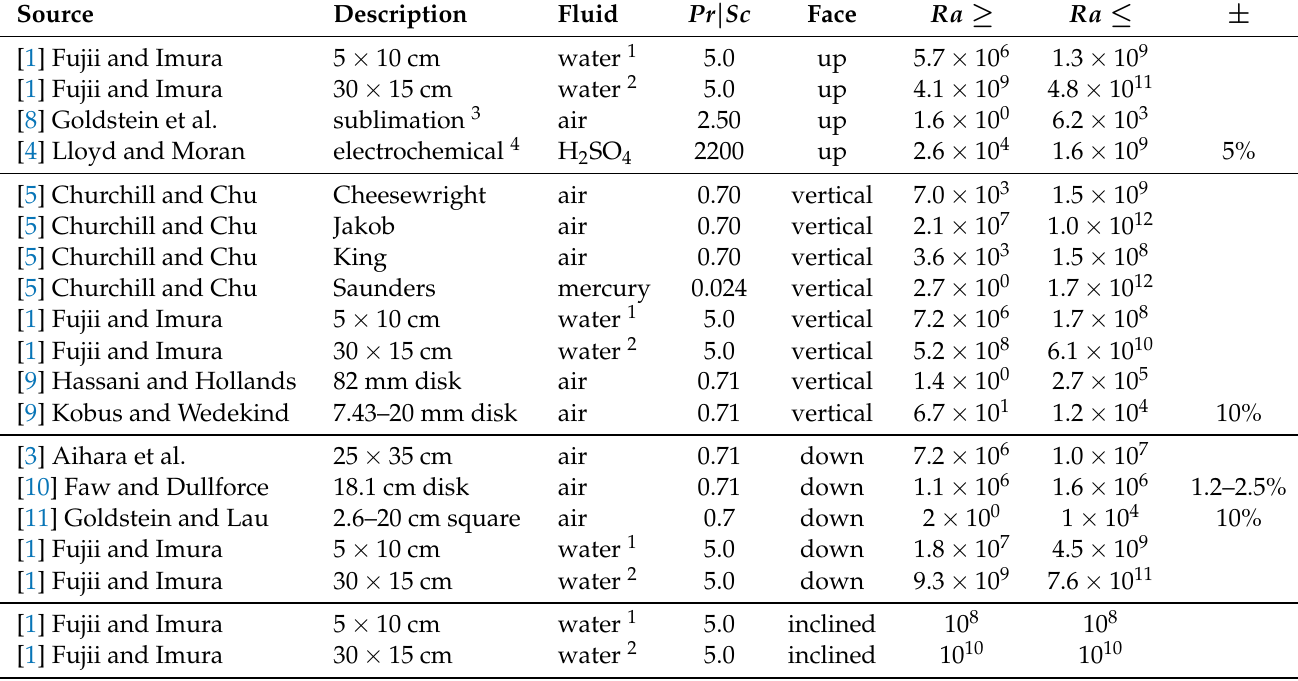
Table 1. Sources of